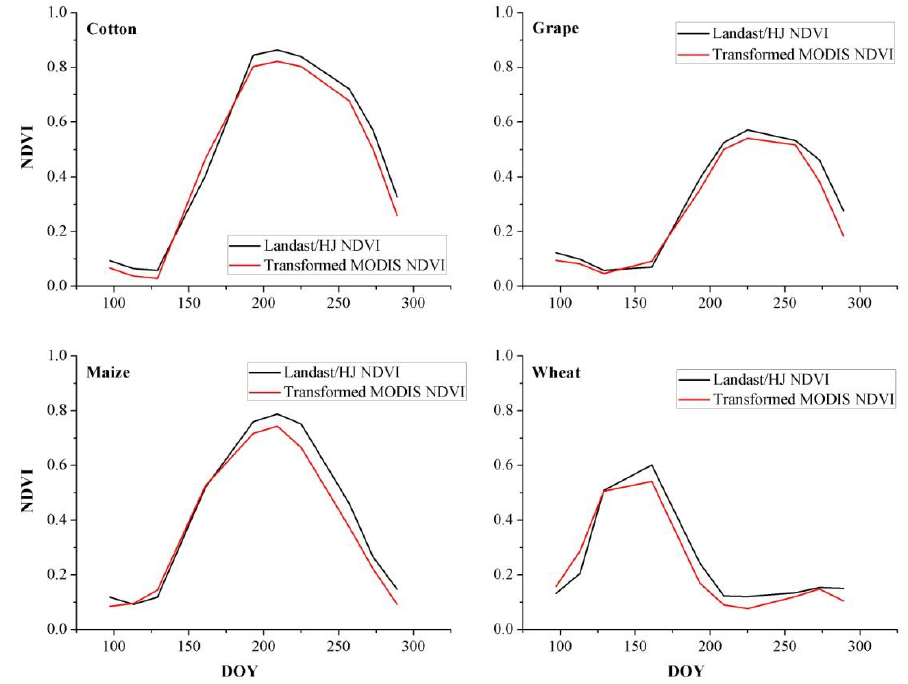
Figure 11. Transformed MODISNDVI and Landsat/HJ NDVI time series in Bole.